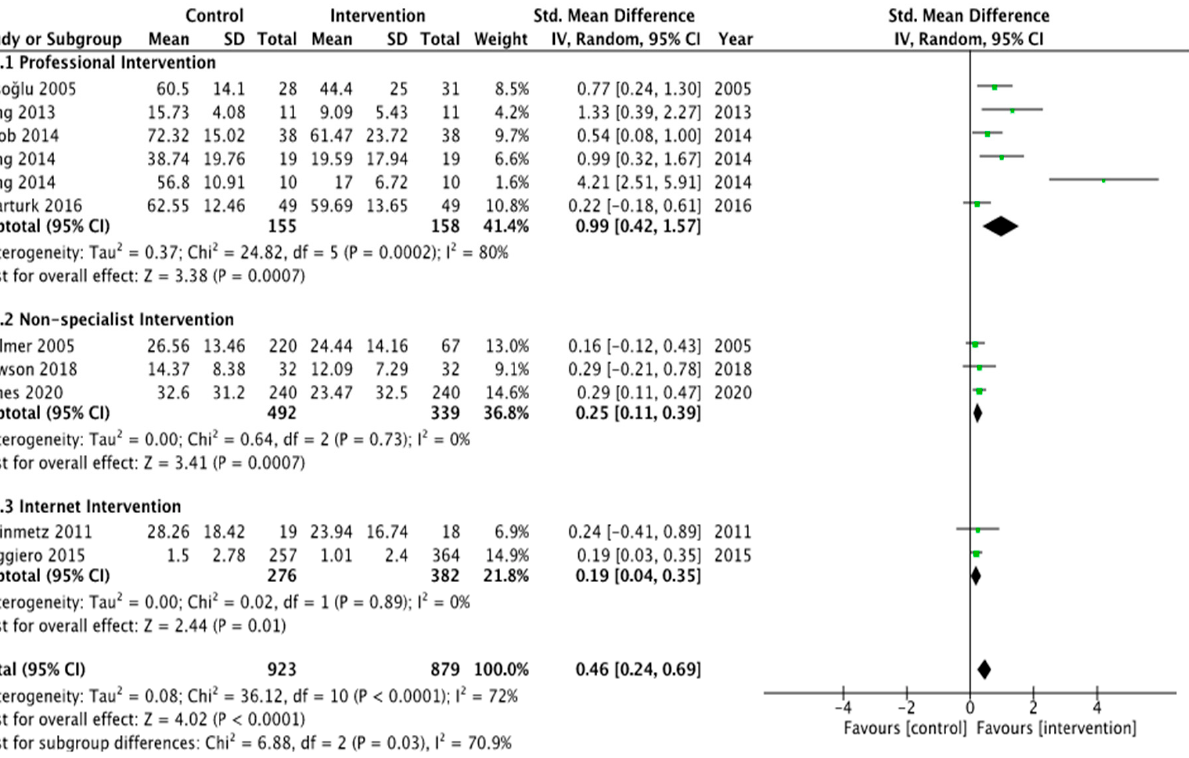
Figure 3. PTSD reduction with professional-delivered mental health interventions compared with PTSD reduction with control group [11,14,27,29,31,35–38,44,46].